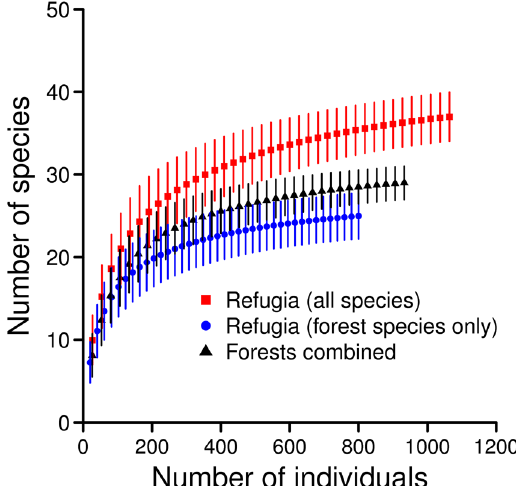
Figure 3. Sample-based rarefaction curves, adjusted for different numbers of individuals, for woody tree species recorded from grassland topographic refugia and forest (five forests combined). Tree species not recorded in forest were removed (i.e. forest species only) from the second refuge curve. Each point represents the mean of 100 randomisations of sample pooling and error bars are 95% confidence intervals. The area sampled in forest was ~3.6-fold greater than the combined sampled area of refuge